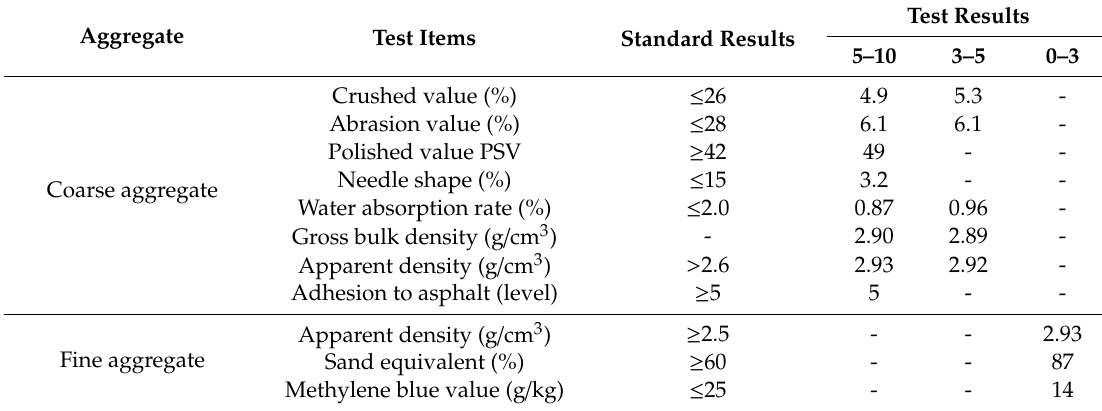
Table 1. Properties of